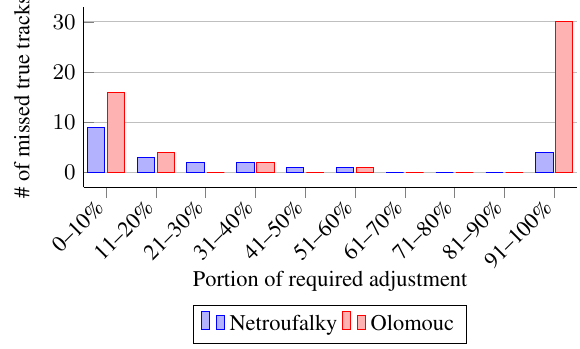
Figure 4. Histogram of missed true tracks, according to required adjustment to best matching